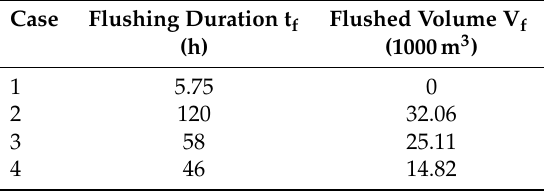
Table 3. Comparison of the total flushed volume during the medium flood